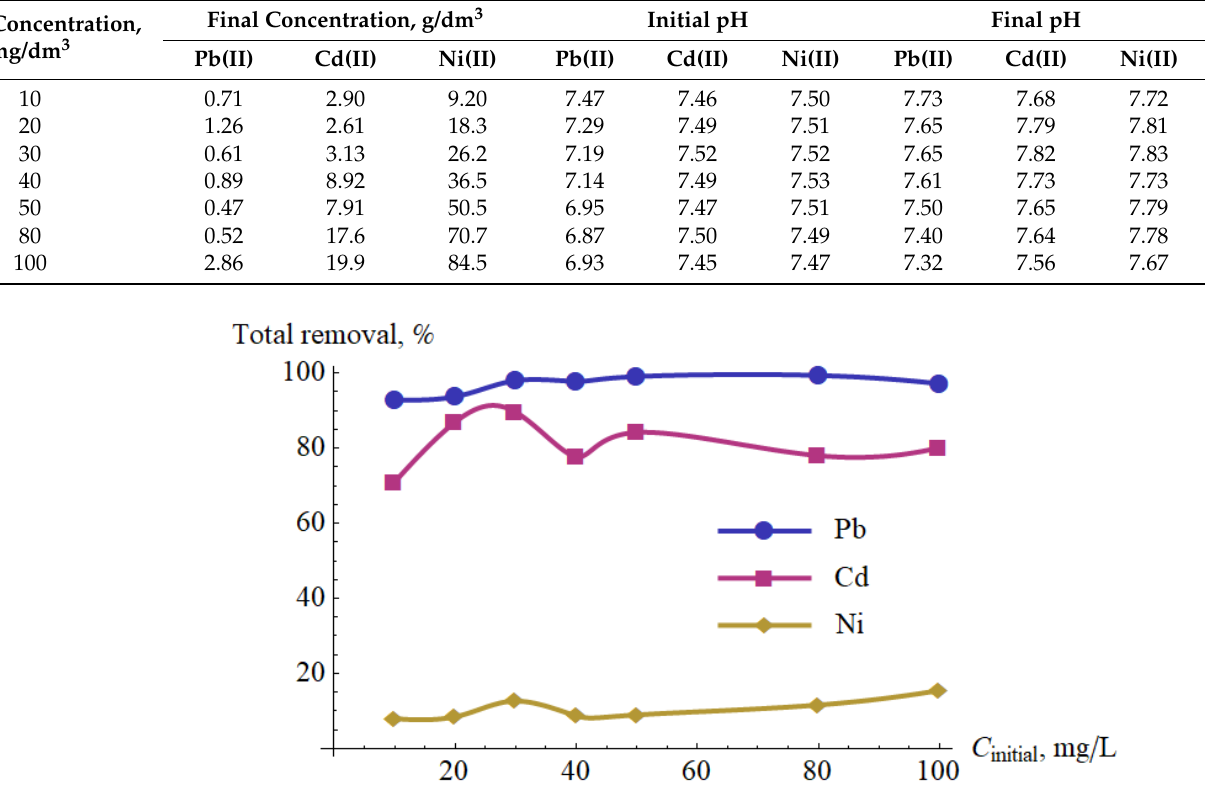
Table 10. Measurement results for various concentrations of Pb(II), Cd(II) and Ni(II) after one pass through the cold plasma reactor.